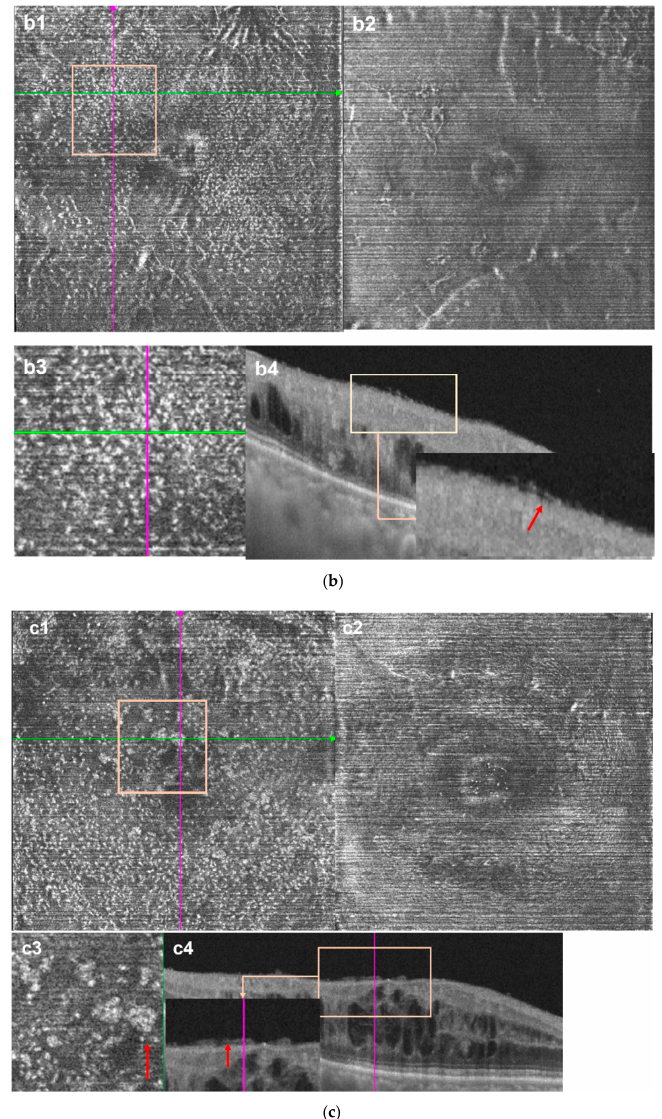
Figure 4. Distribution and morphology characteristic of MLCs. ( a ) The distribution and morphology of MLCs were different between normal, acute BRVO, and chronic BRVO eyes. ( a1 , a4 ) En face OCT image and the magnified image from the normal eye. The distribution of MLCs was relatively even. ( a2 , a5 ) En face OCT image and the magnified image from the acute RVO eye. Some MLCs congregated and the signal of MLCs was enhanced. ( a3 , a6 ) En face OCT image and the magnified image from the chronic RVO eye. MLCs were larger. Highly reflective clumpy structures (red arrow) and retinal folds (yellow arrow) are shown. ( b , c ) Images from chronic RVO eyes. ( b1 – b4 ) Images from a chronic BRVO patient with long-lasting retinal edema for more than 2 years. ( b1 ) En face OCT slab from the affected eye. ( b2 ) The en face OCT slab from the fellow eye, MLCs were barely visible. ( b3 ) Magnified partial image from ( b1 ). MLCs were larger and congregated. ( b4 ) OCT B-scan and the magnified image on the green line in ( b1 ). Retinal edema was shown. Connections between the MLCs (red arrow) are visible. ( c1 – c4 ) Images from a chronic BRVO patients with retinal edema. Compared with the fellow eye, the affected eye presented significantly increased MLCs with a clump-like structure. ( c1 ) En face OCT slab from the affected eye. ( c2 ) En face OCT slab from the fellow eye. ( c3 ) Magnified partial image from ( c1 ), hyperreflective clump-like structures are shown (red arrow). ( c4 ) OCT B-scan and the magnified image on the green line in ( c1 ), hyperreflective clump-like structures on B-scan are shown (red arrow). The purple line corresponded to the line of same color in ( c1